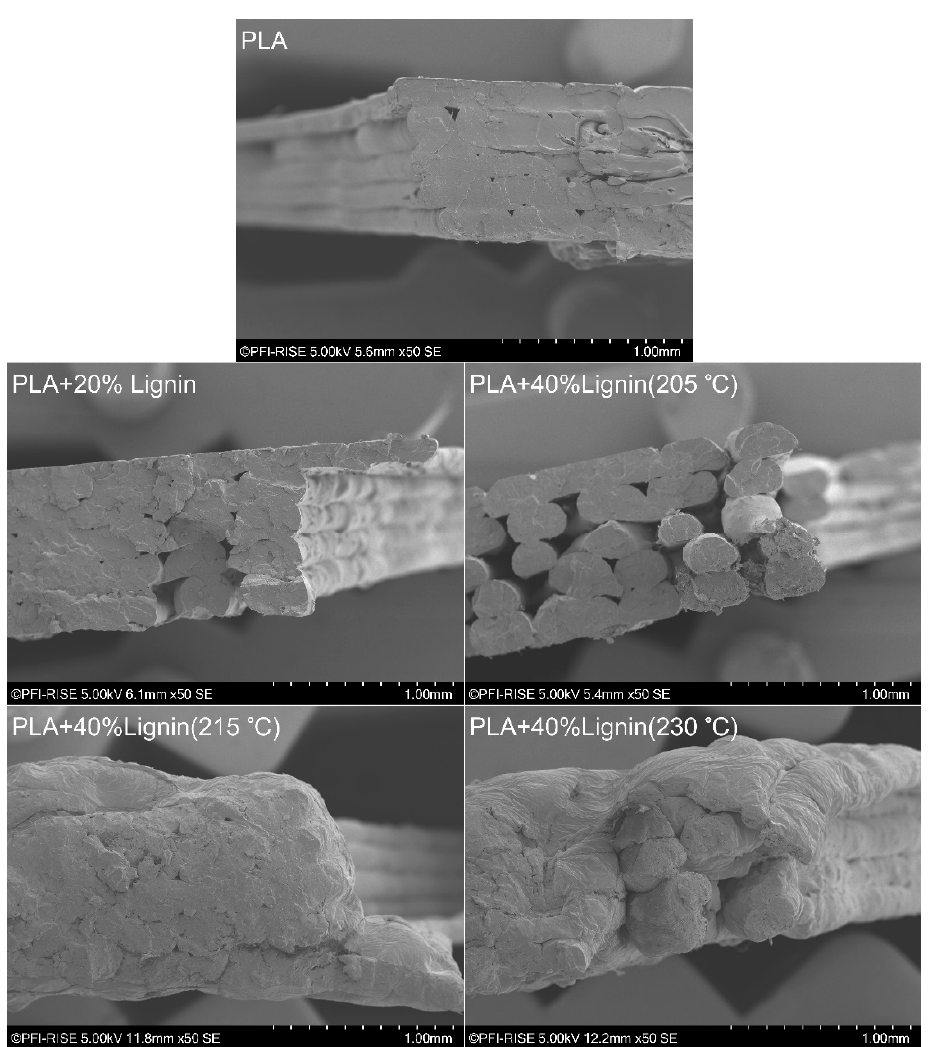
Figure 5. Scanning electron microscopy (SEM) analysis of the fracture surface of tensile tested dogbones .